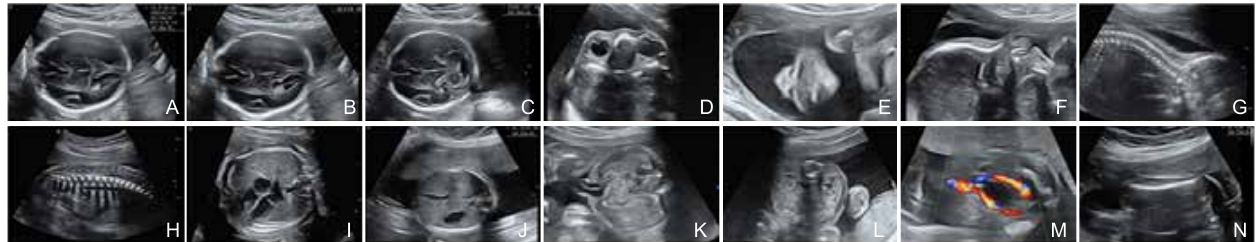
Figure 1 Standard fetal views automatically acquired by Sonoscape S-Fetus 4.0. (A) Transection of the thalamus; (B) Transection of lateral ventricle; (C) Transection of cerebellar; (D) Transection of the eyeballs; (E) Nasolabial coronal section; (F) Facial profile; (G) Sagittal section of cervicothoracic